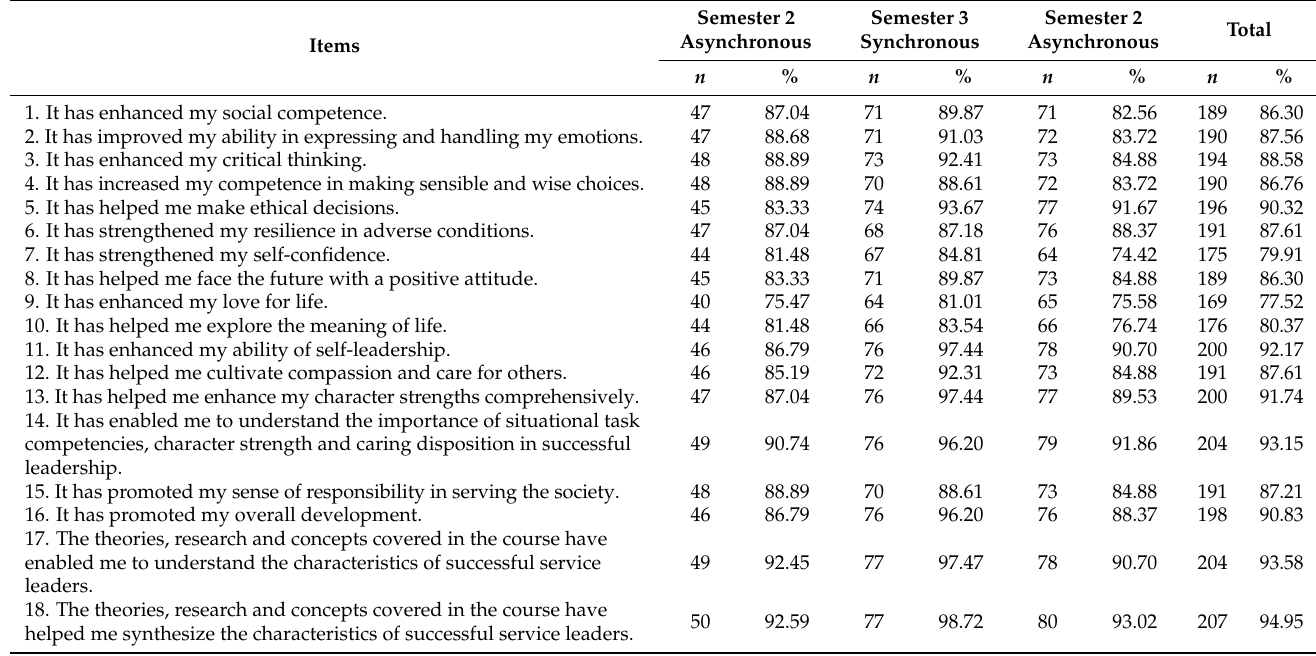
Table 4. Respondents with positive responses (options 4–5) regarding participants’ perceived course benefits.